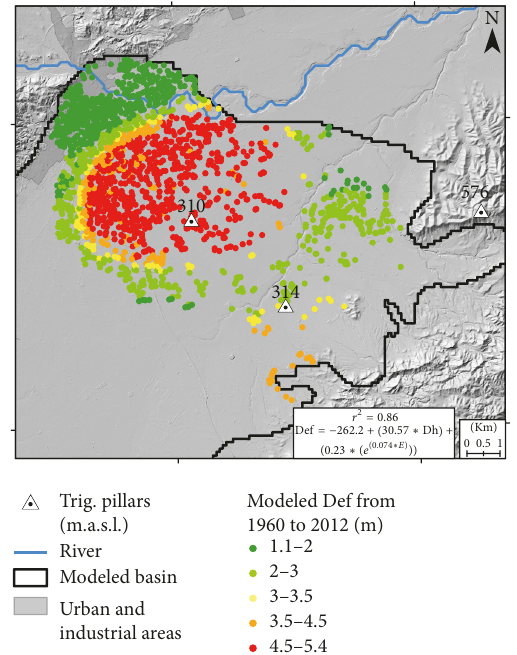
Figure 12: Estimated deformation from 1960 to 2012 using the groundwater model